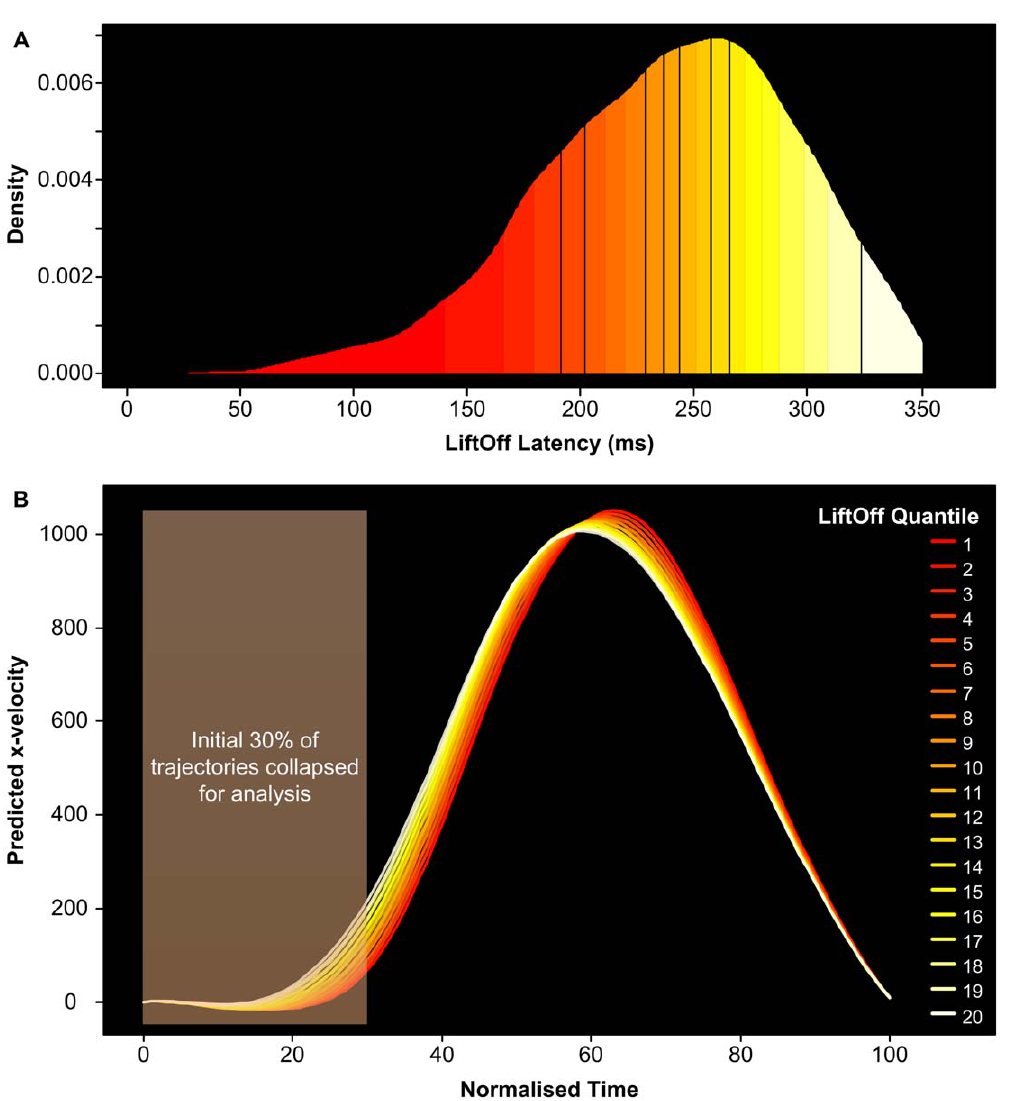
Figure 3. Grouping trajectories by Target-Viewing Time. (A) Analysis begins with the distribution of LiftOff Latencies (i.e. Target-Viewing times), estimated relative to target onset. A modified version of OPTA is used to fit a polynomial regression model to the x-velocity profile for each trial. The model includes LiftOff Latency percentile as a covariate (see text). (B) Predicted x-velocity profiles are grouped into semi-decile intervals. Red colours indicate trials with short LiftOff Latencies (beginning at the 1 st semi-decile); white-colours correspond to longest LiftOff Latencies (20 th semi- decile). Note the clear effect of LiftOff Latency: the longer subjects wait to begin moving, the faster the finger moves in the correct direction.